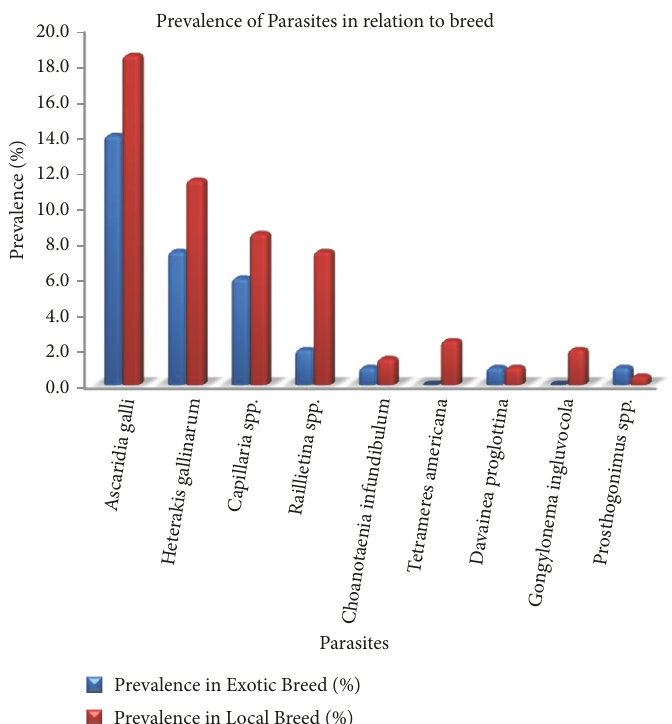
Figure 1: A chat showing prevalence of gastrointestinal helminths of local and exotic breeds of chicken in Pankrono-Kumasi Ghana.